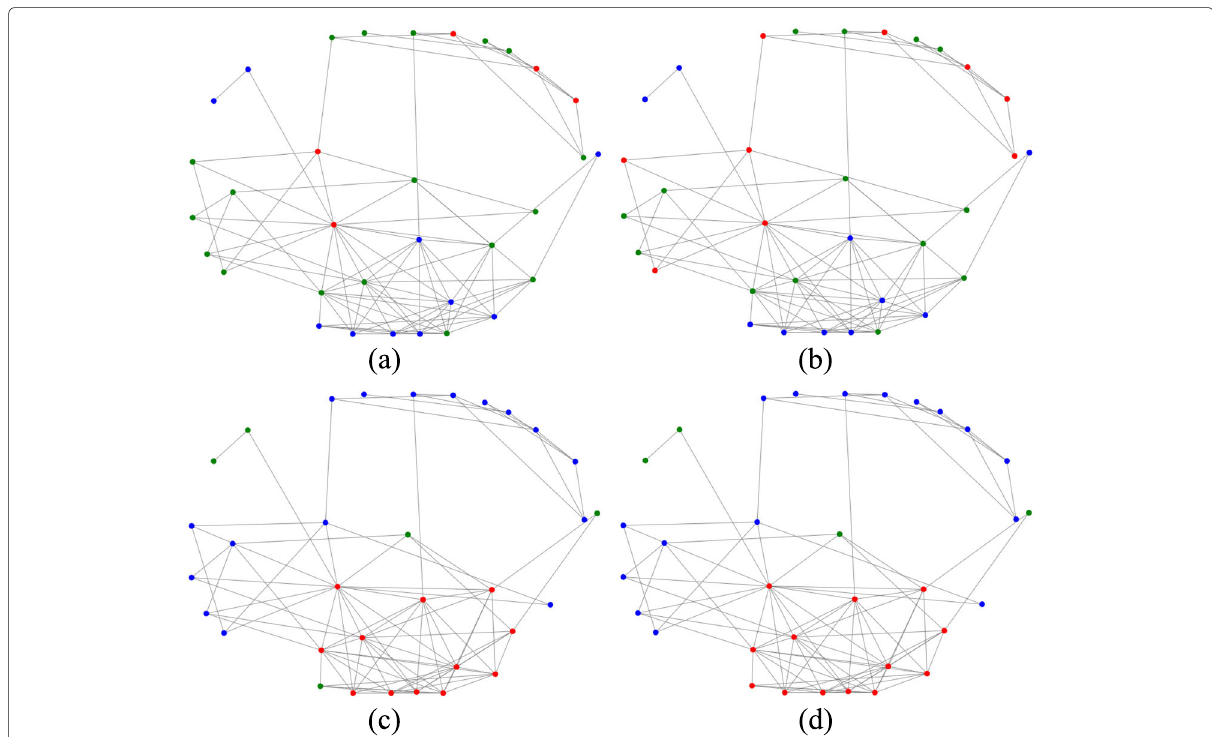
Fig. 6 DBLP network with missing link probability (cid:3) 2 = 0.3: comparison of the two detected communities with the ground-truth by using the proposed noise-aware game-theoretic algorithm and the AGM in [15], respectively. The nodes’ colors have the same meaning as in Fig. 3. a Detection of community 1 with AGM; b Detection of community 1 with the proposed noise-aware game-theoretic algorithm; c Detection of community 2 with AGM; d Detection of community 2 with the proposed noise-aware game-theoretic algorithm